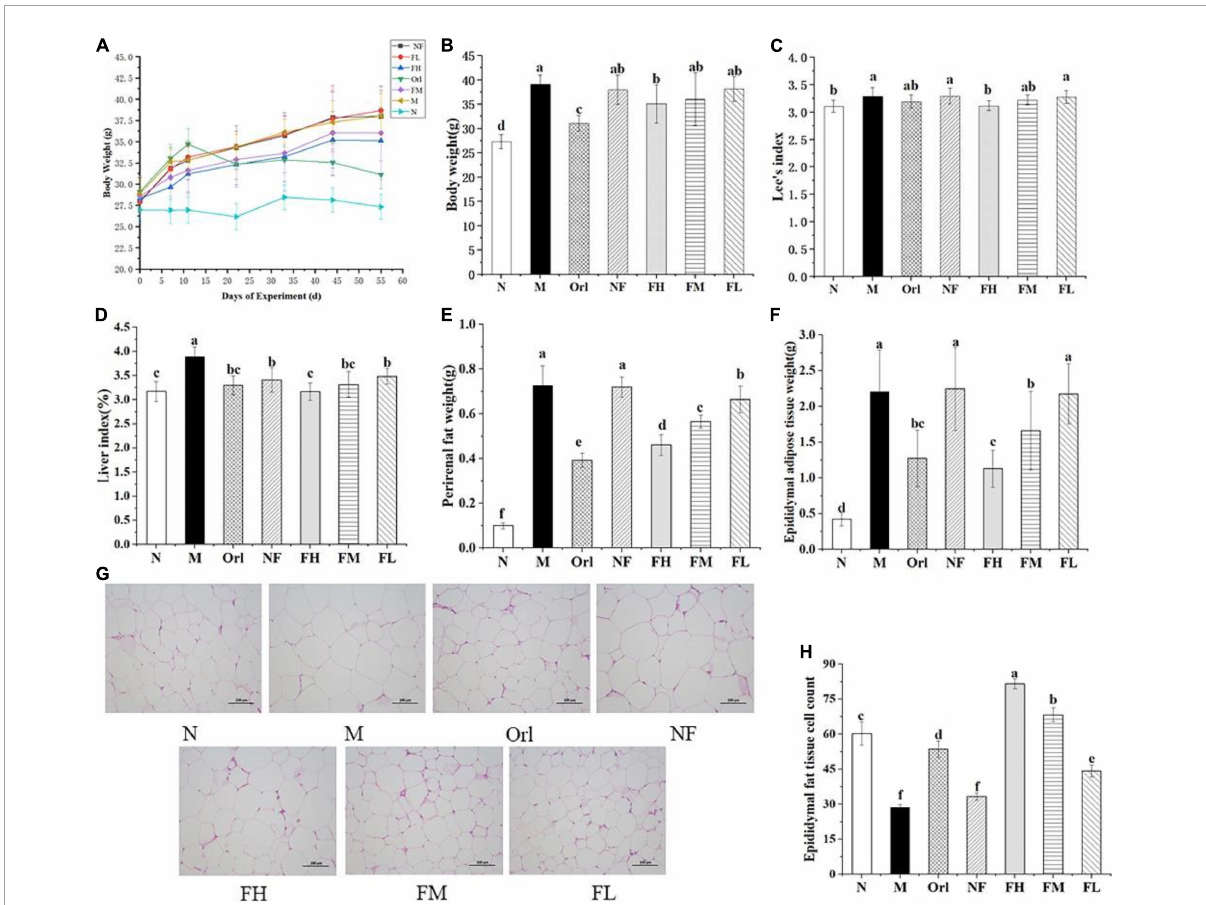
FIGURE1 FAK ameliorates HFD-induced obesity in mice. Effects of FAK on Body weight change (A) ; final body weight (B) ; Lee’s index (C) ; liver index (D) ; perirenal fat weight (E) ; epididymal adipose tissue weight (F) ; H&E staining of epididymal adipose tissue (scale bar = 100 µ m) (G) ; and adipocytes count (H) in each group. All data are expressed as mean ± SD ( n = 5). (a–f) Bands with different letters indicate significant differences ( P <